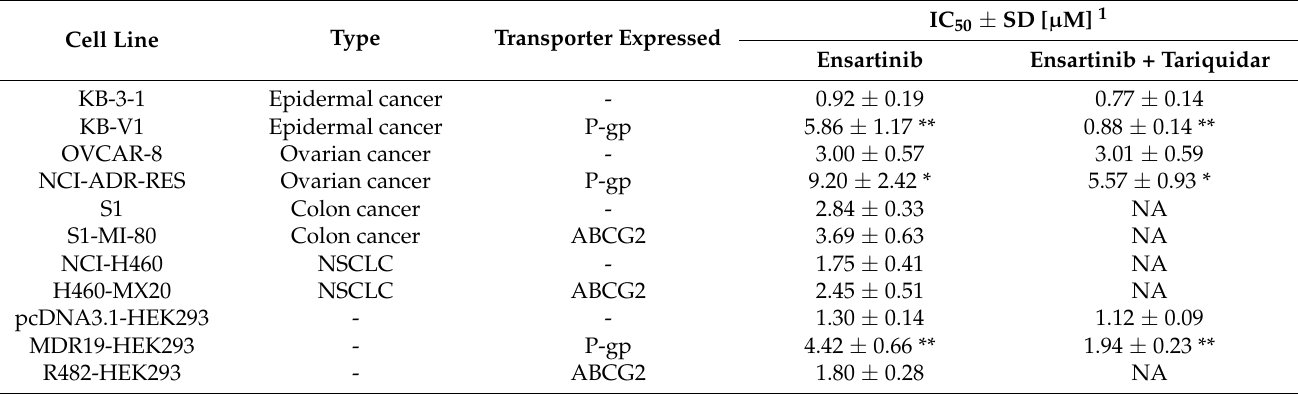
Figure 1. The antiproliferative effect of ensartinib is reduced in cells overexpressing P-glycoprotein. The cytotoxicity of ensartinib in ( a ) KB-3-1 (open circles) and the P-gp-overexpressing subline KB-V1 (filled circles); ( b ) OVCAR-8 (open circles) and the P-gp-overexpressing subline NCI-ADR-RES (filled circles); as well as ( c ) pcDNA3.1-HEK293 (open circles) and the P-gp-transfected MDR19-HEK293 (filled circles), was determined as described previously [39]. The values were mean ± SEM calculated from at least three independent experiments. Insets are representative immunoblots showing P-gp and tubulin in parental and P-gp-expressing cells. Table 1. Cytotoxicity of ensartinib in drug-sensitive and multidrug-resistant cells overexpressing either P-glycoprotein or ABCG2.